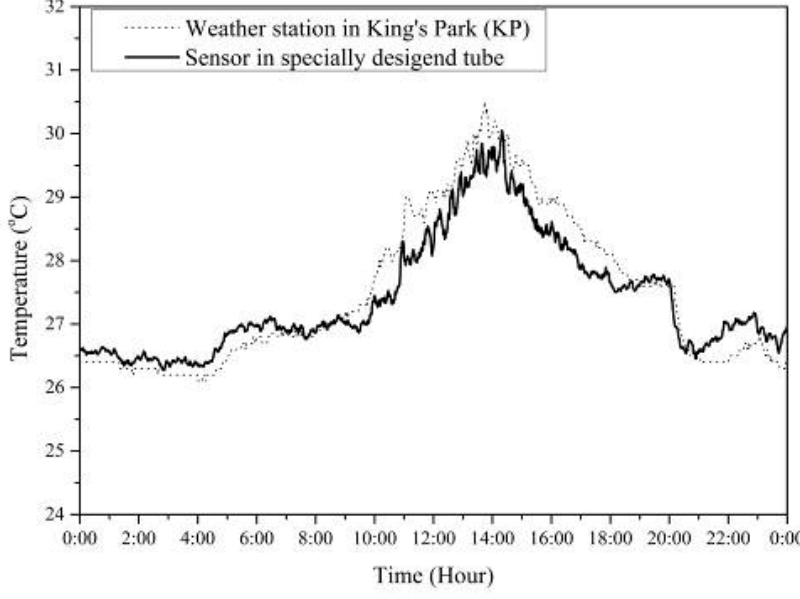
Figure A1. Temperatures obtained from weather stations at King’s Park and the specially designed tube (instrument used for the present study) on 21 July 2013.